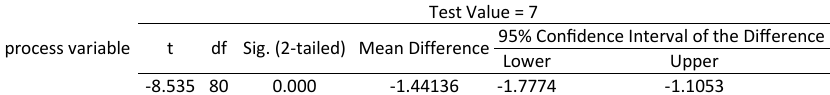
Table 4 : One-sample t-test of process variable